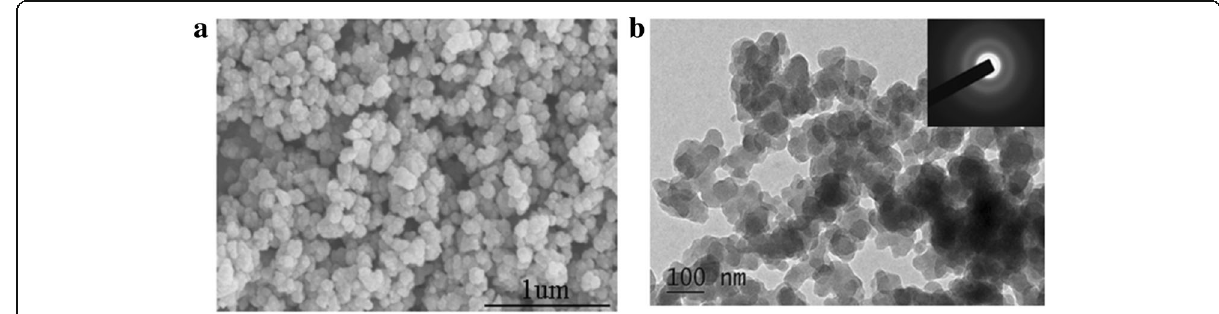
Fig. 2 Morphology of RP NPs. a SEM images of RP NPs. b TEM images of RP NPs. The inset image is the SAED pattern